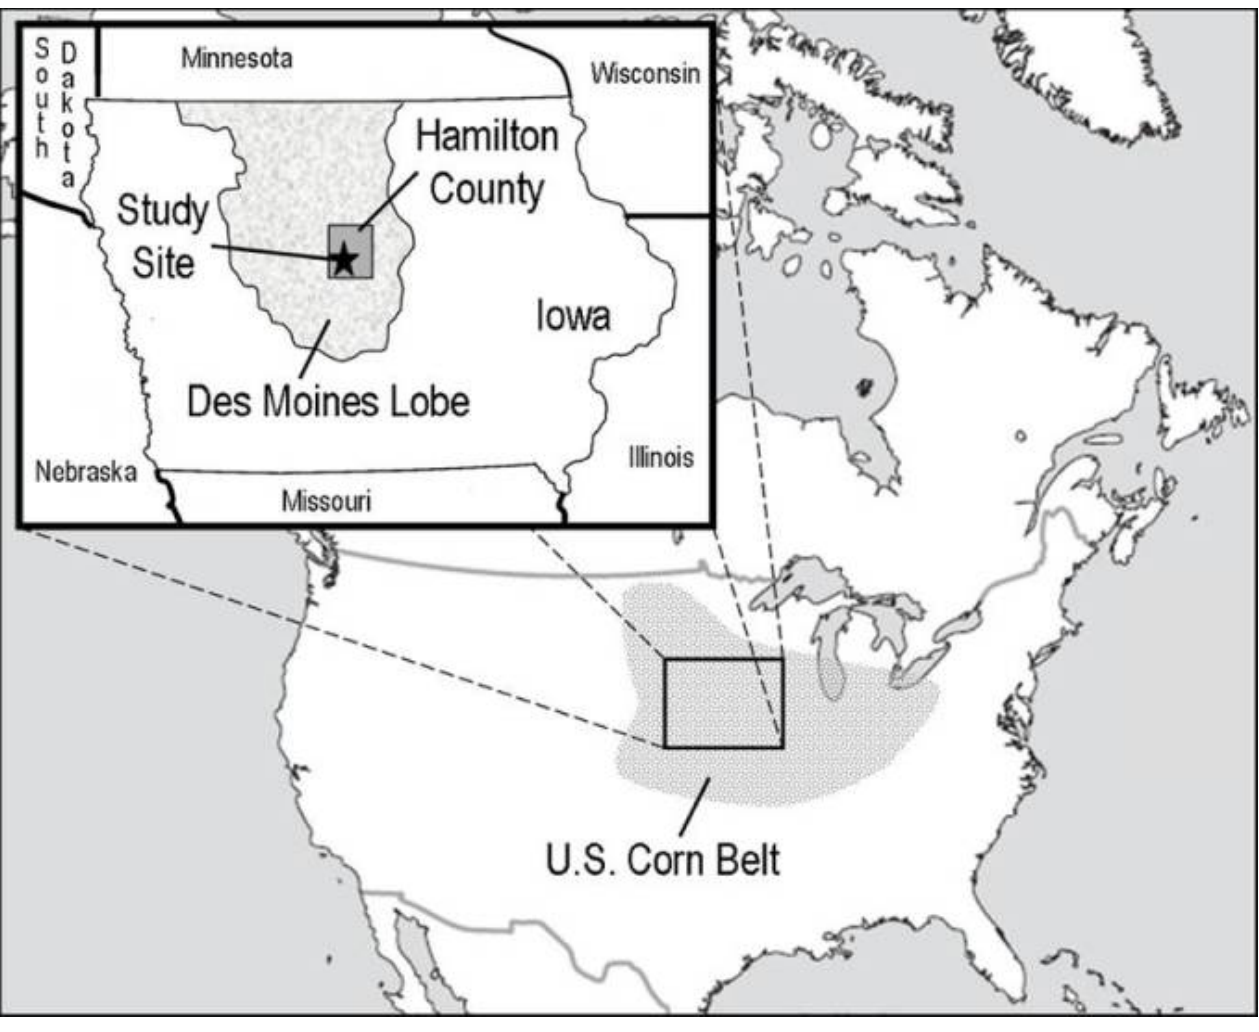
Fig. 1 . Our study site is a rural agricultural community situated in the middle of the Des Moines Lobe ecoregion in southwest Hamilton County, Iowa,